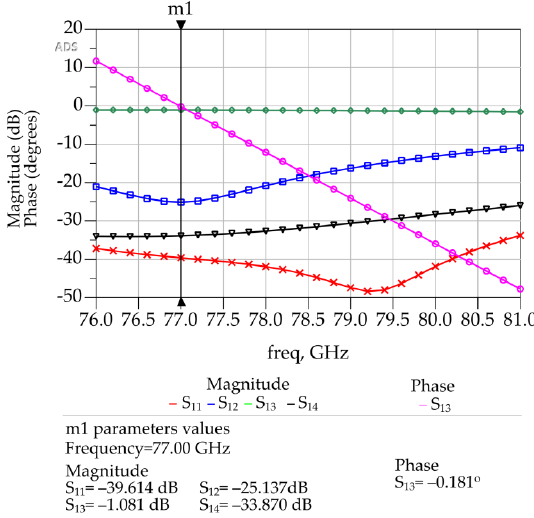
Figure 11. ADS generated 3D FEM simulation results of the type-2 crossover.